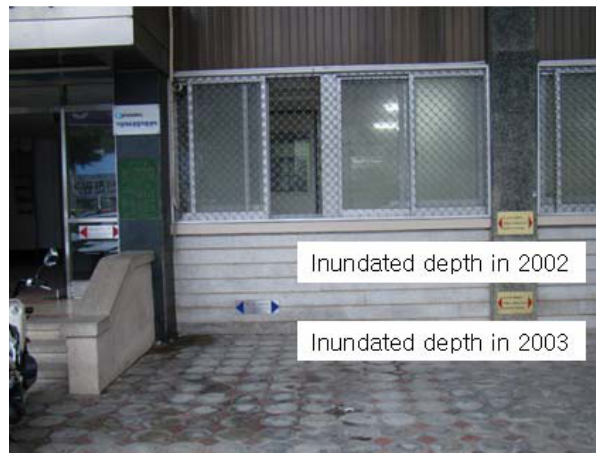
Fig. 4. A inundated depths after Fig. 4. Inundated depths after flooding. flooding